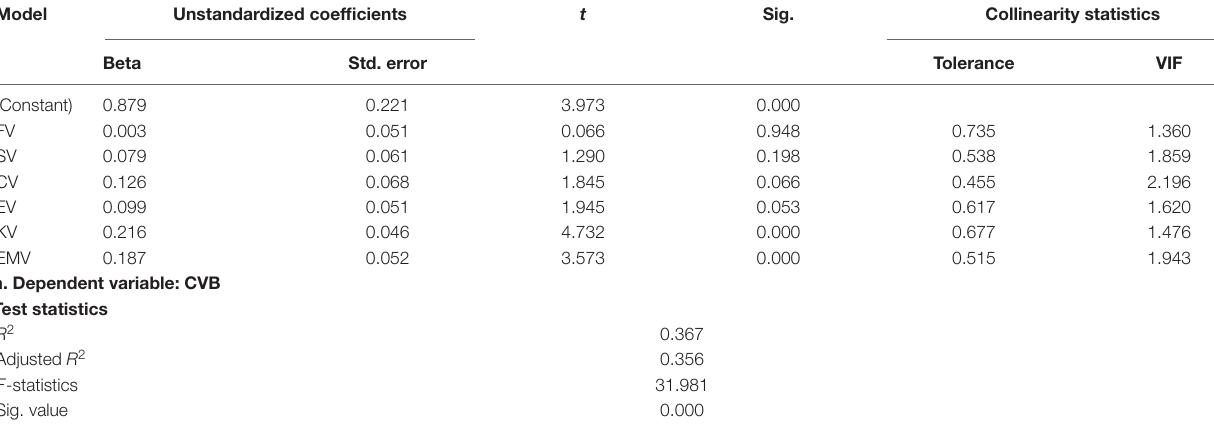
TABLE 10 | Regression results among the variables (China).